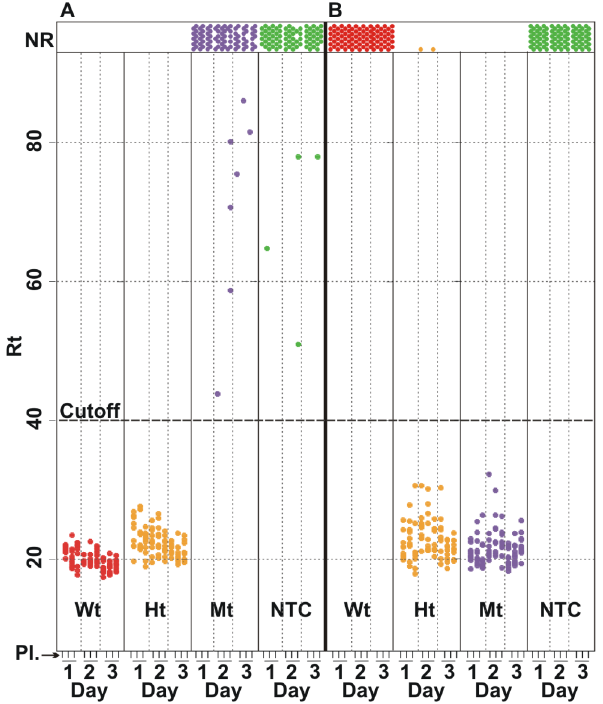
Figure 4. RAM assay data from C-probes ligated on genomic DNA targets. Panels A and B show the RAM response times (Rt) for DNA samples hybridized to the Wt- and Mt-detecting C-probes, respectively. Columns within panels are labeled with the target DNA genotype or with ‘‘NTC’’ (no-target control). Rt signals from nine RAM plates (‘‘Pl’’; see Figure 3) that were run on each of three days (Day) are shown vertically in columns. Each NR result is shown in the top panel (NR).